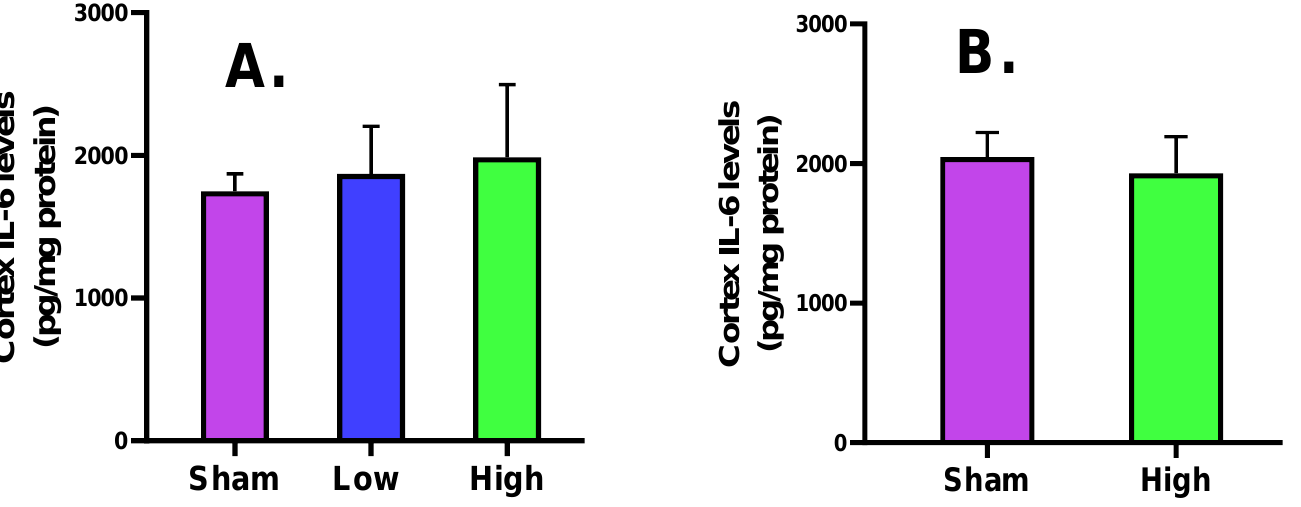
Figure 5. Effect of tDCS-iTBS on cortical IL-6 levels (pg/mg protein): ( A ) short-term ( n = 15) and ( B ) long-term stimulations ( n = 16).